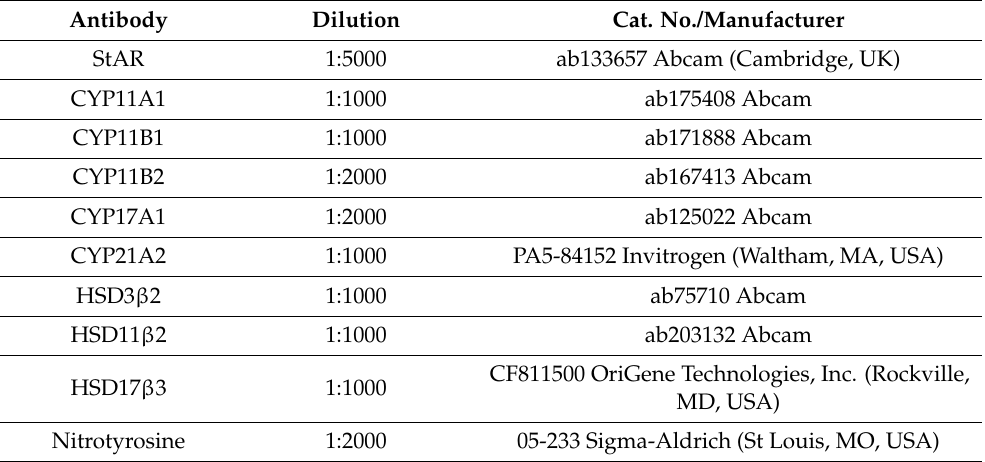
Table 1. List of primary antibodies used for western blot